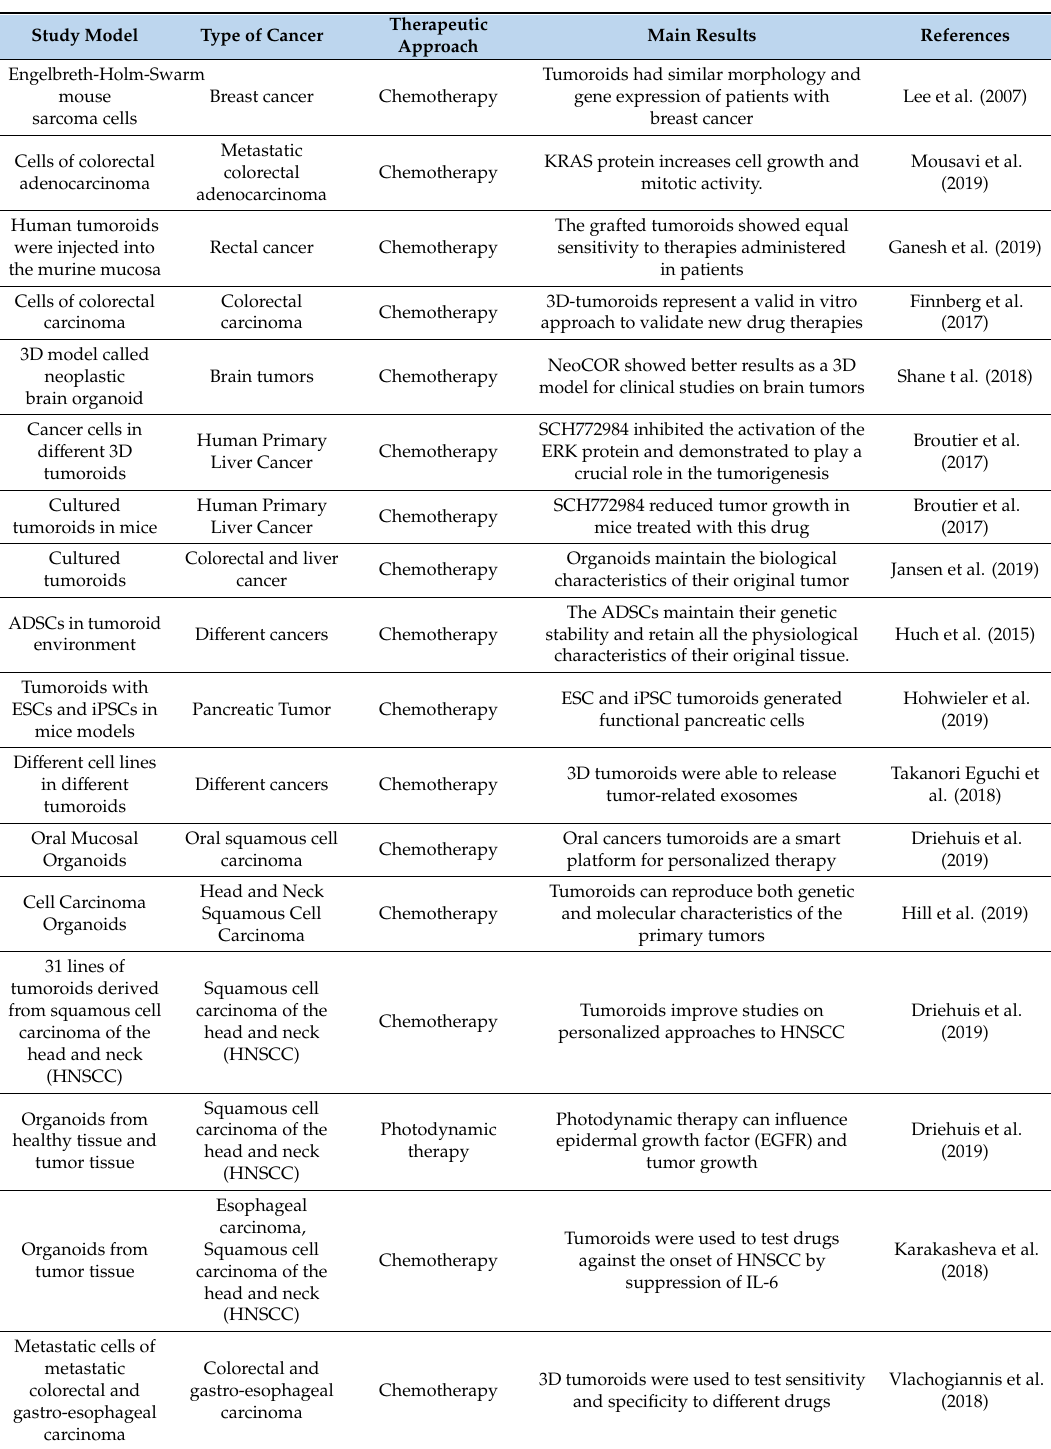
Table 1. Tumoroids: in vitro and in vivo